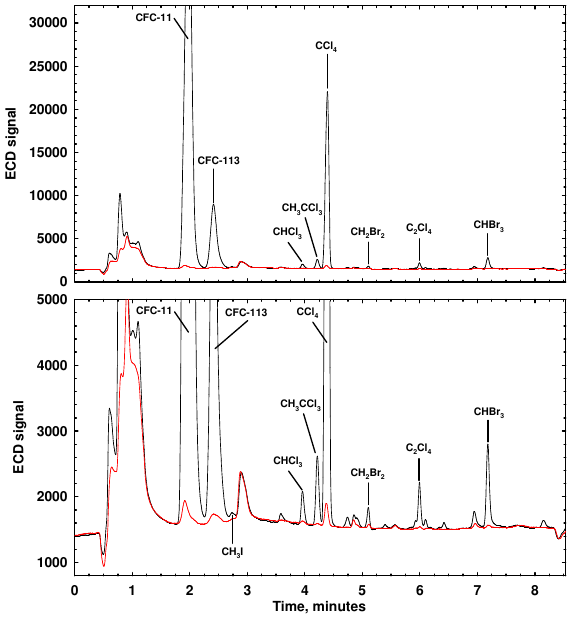
Fig. 8. (upper panel) Sample (black trace) and blank (red trace) chromatograms from the Cape Verde campaign in June 2007. (lower panel) Same chromatograms as upper panel but zoomed in to more closely show the baseline, including smaller target peaks and blank